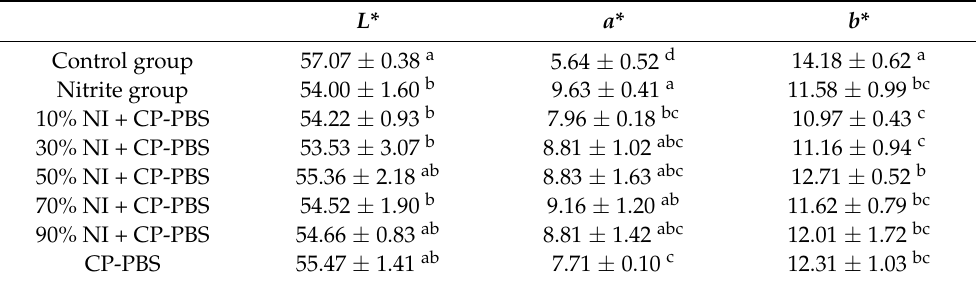
Table 3. Effect of different treatments on the color of smoked